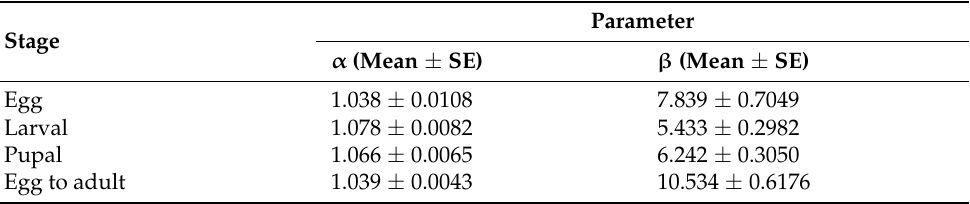
Table 6. Estimated parameter values of development distribution model for Feltiella acarisuga